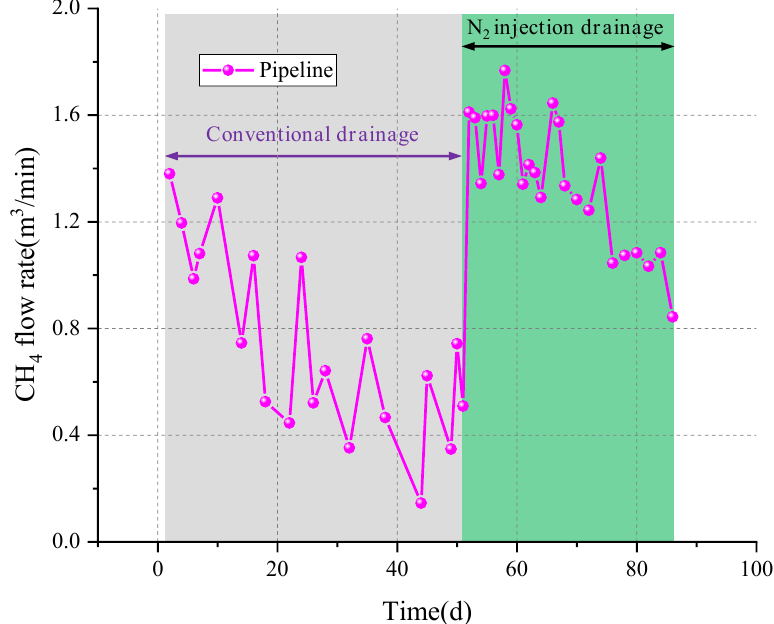
Figure 11. CH 4 flow rate of pipeline with respect to time.